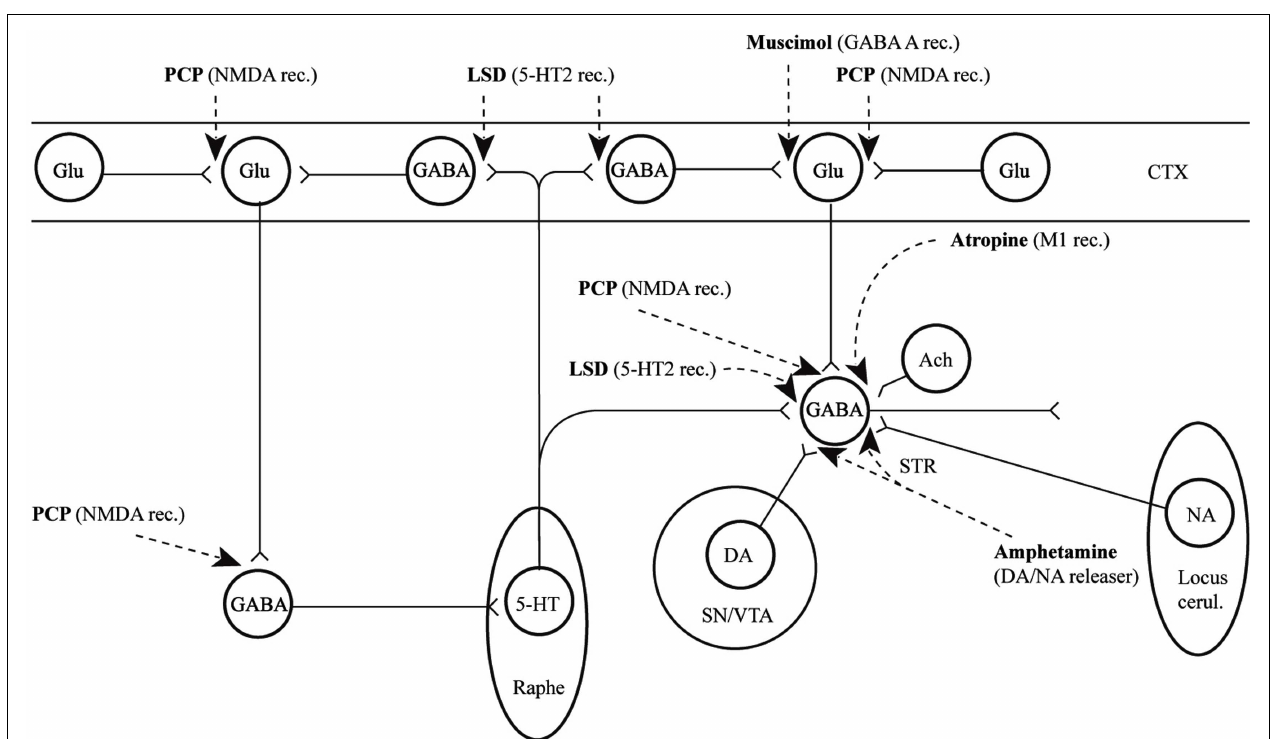
supposed to be psychotogenic by enhancing on striatal dopamine release and blocking NMDA receptors, respectively.These actions are partly located in the (limbic) striatum, partly in other sites. For example, PCP may act by blocking cortical NMDA receptors as well, e.g., in the hippocampus, as indicated in the figure, leading to reduced tone in corticostriatal glutamatergic pathways. KEY: CTX cortex, STR striatum, SN substantia nigra,VTA ventral tegmental area [With Permission Carlsson et al. (1999) and Biological